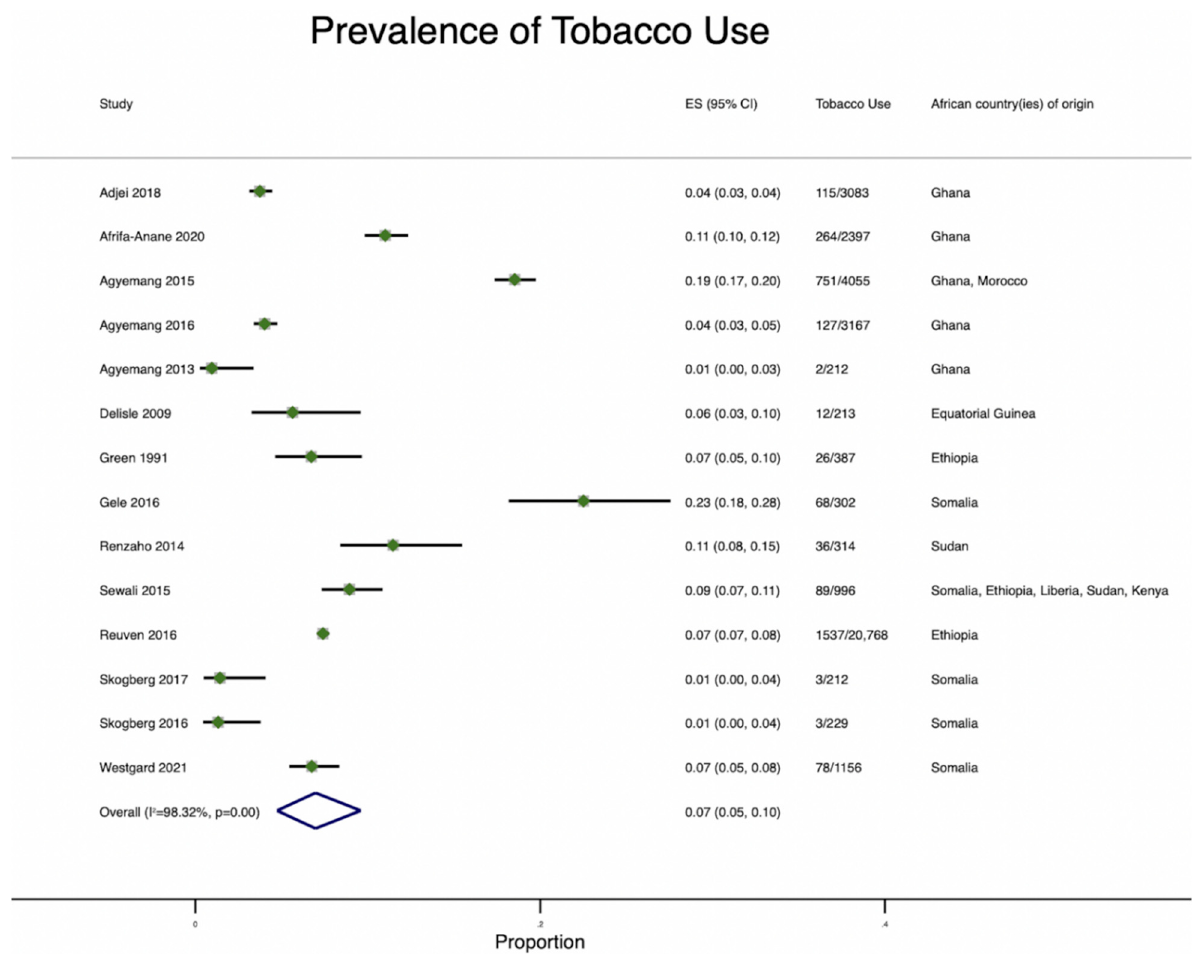
Figure 6. Pooled Prevalence of tobacco use among African immigrants residing in high-income countries.